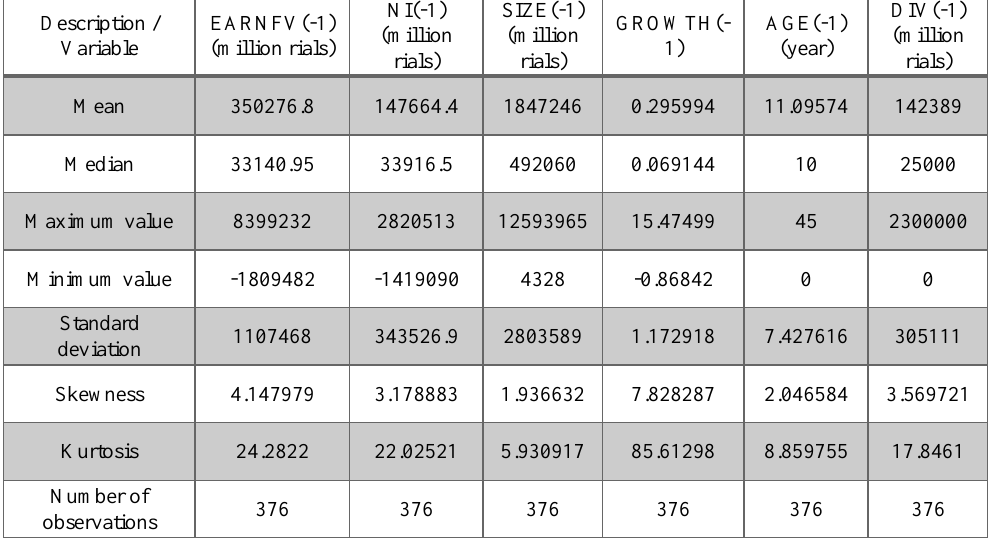
Table 2 . Descriptive statistics of the first and second hypotheses - lagged variables